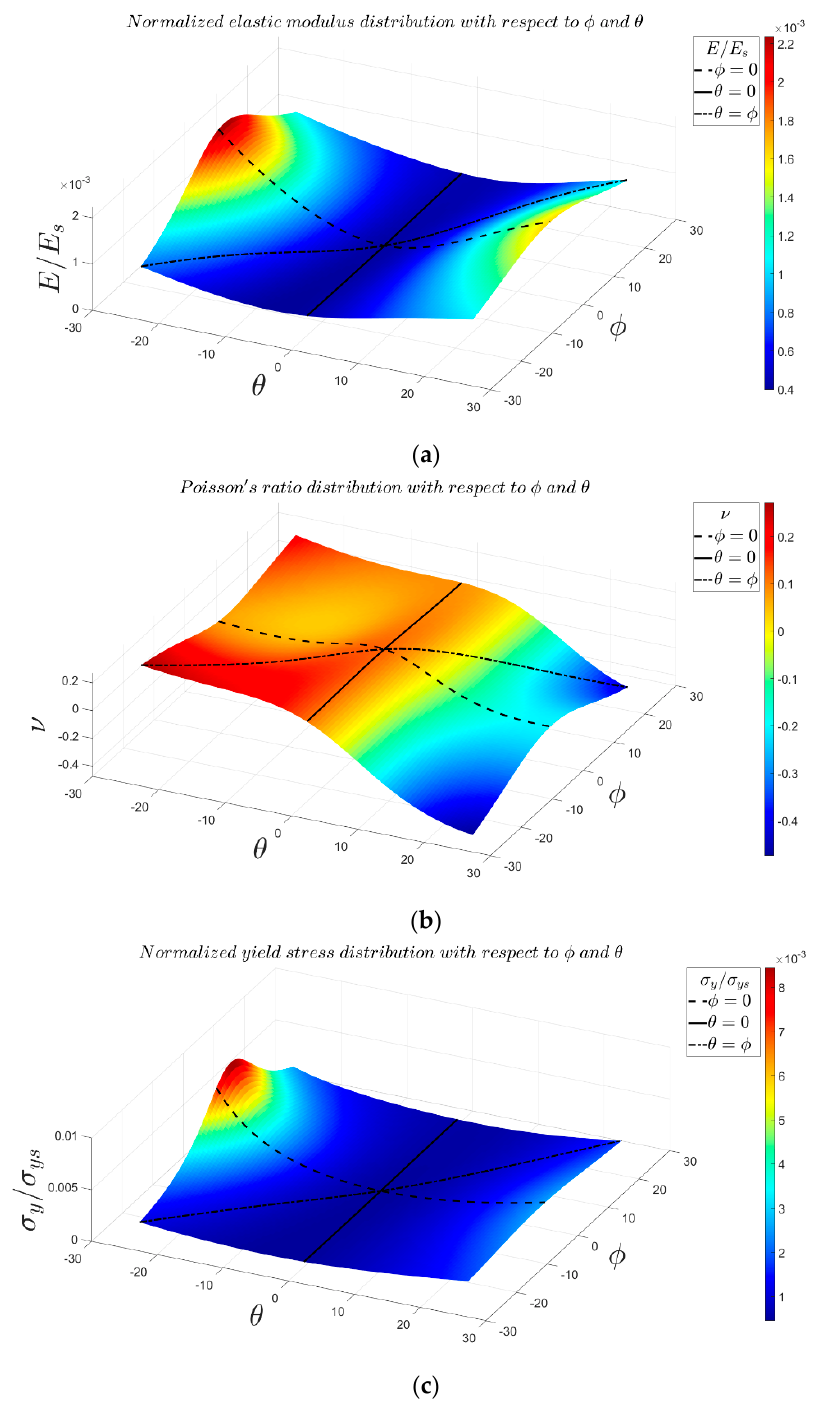
Figure 12. Variations of mechanical properties of general 3D re-entrant unit cell with respect to angles 𝜃 and 𝜑 for 𝑟 (cid:2869) = 𝑟 (cid:2870) = 𝑟 (cid:2871) = 0.14𝑏 : ( a ) elastic modulus, ( b ) Poisson’s ratio, and ( c ) yield stress. Specific cases of 𝜃 = 0°, 𝜑 = 0°, and 𝜃 = 𝜑 are marked with solid, dashed, and dashed-dot lines, respectively.